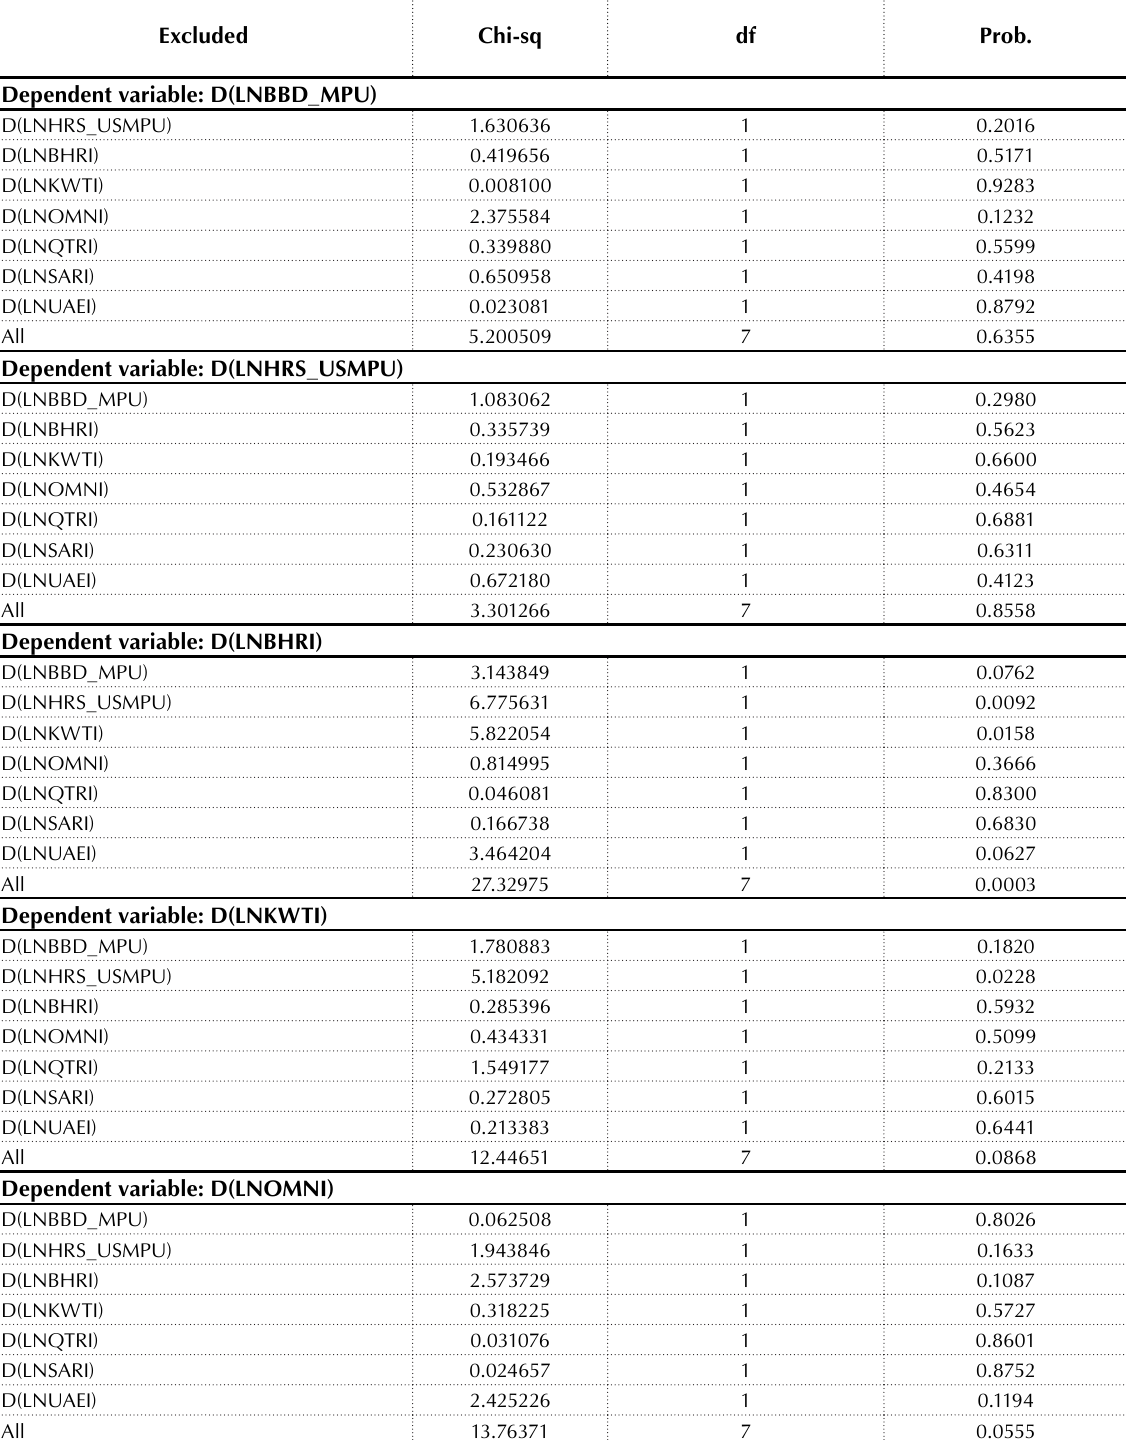
Table A4. Block exogeneity